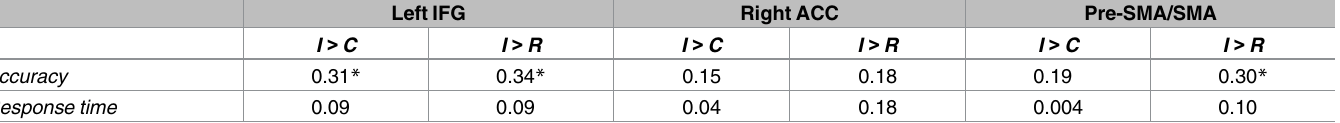
Table 6. Pearson correlations of percent signal change between conditions of the fMRI Color-Word Stroop task in three regions of interest (pre- SMA/SMA, right ACC, and left IFG) during the and performanceon the Behavioral Color-Word Stroop task outside of the scanner. Left IFG Right ACC Pre-SMA/SMA I >